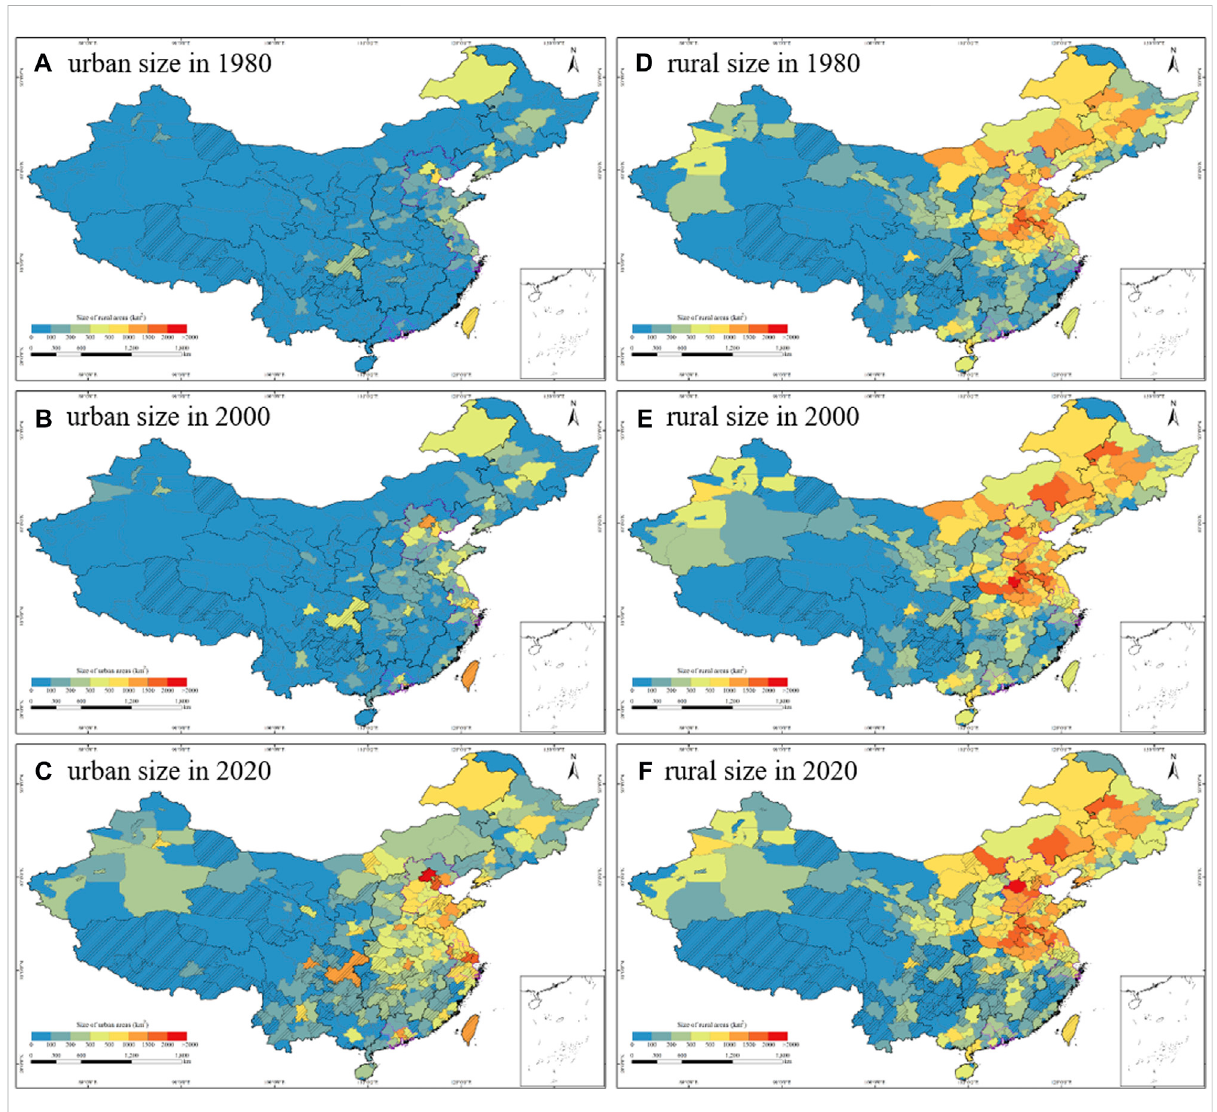
FIGURE 3 Urban and rural sizes at each prefecture of China in 1980 and 2020. Note: The shaded prefectures indicate urban size larger than rural